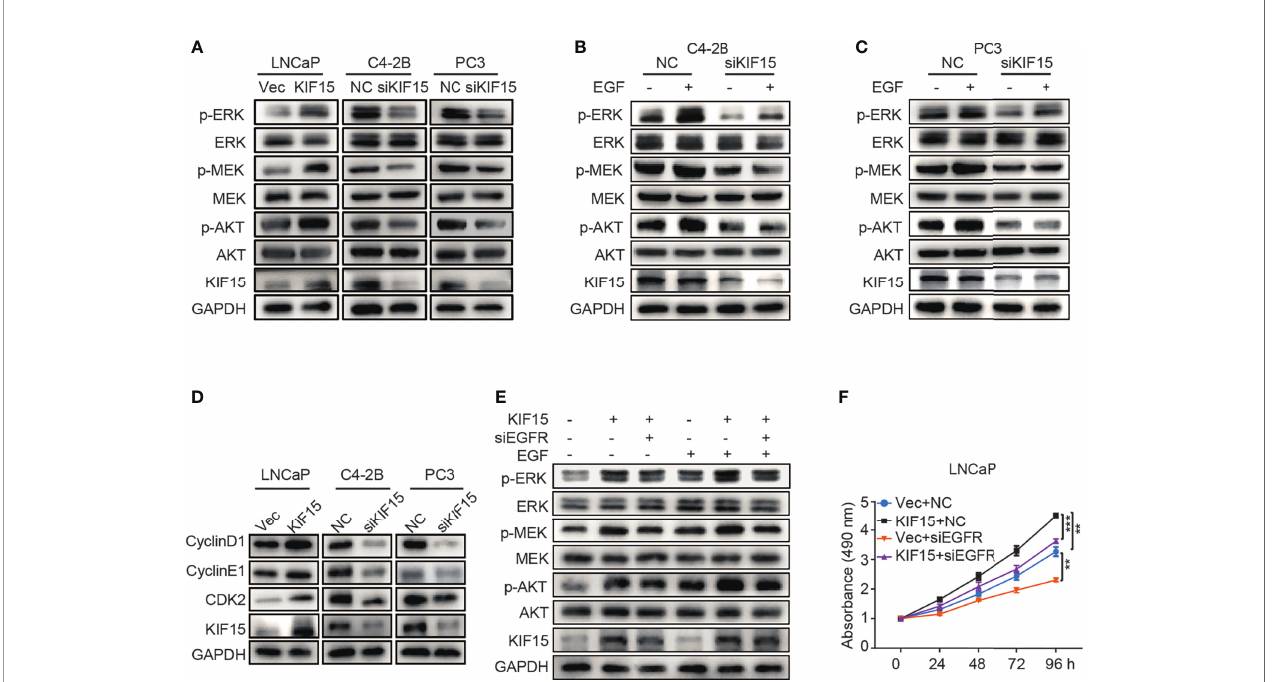
FIGURE 4 | KIF15 activates EGFR signaling in CRPC cells. (A-C) Expression of the key molecules in MAPK and PI3K-AKT signaling pathways determined by Western blot in KIF15-overexpressed or depleted PCa cells with or without 20 ng/ml EGF treatment for 20 minutes. (D) The expression of cell cycle-related proteins, CyclinD1, CyclinE1, and CDK2 determined by Western blot in the indicated PCa cells with KIF15 overexpression or depletion. (E) Expression of the key molecules in MAPK and PI3K-AKT signaling pathways determined by Western blot in KIF15 overexpressed and EGFR depleted LNCaP cells with or without 20 ng/ml EGF treatment for 20 minutes. (F) Cell proliferation of LNCaP cells assessed by MTS assays. LNCaP cells were transiently transfected with the indicated expression plasmids and/or siRNA, and cell proliferation was assessed by MTS assays. ** P < 0.01; *** P <